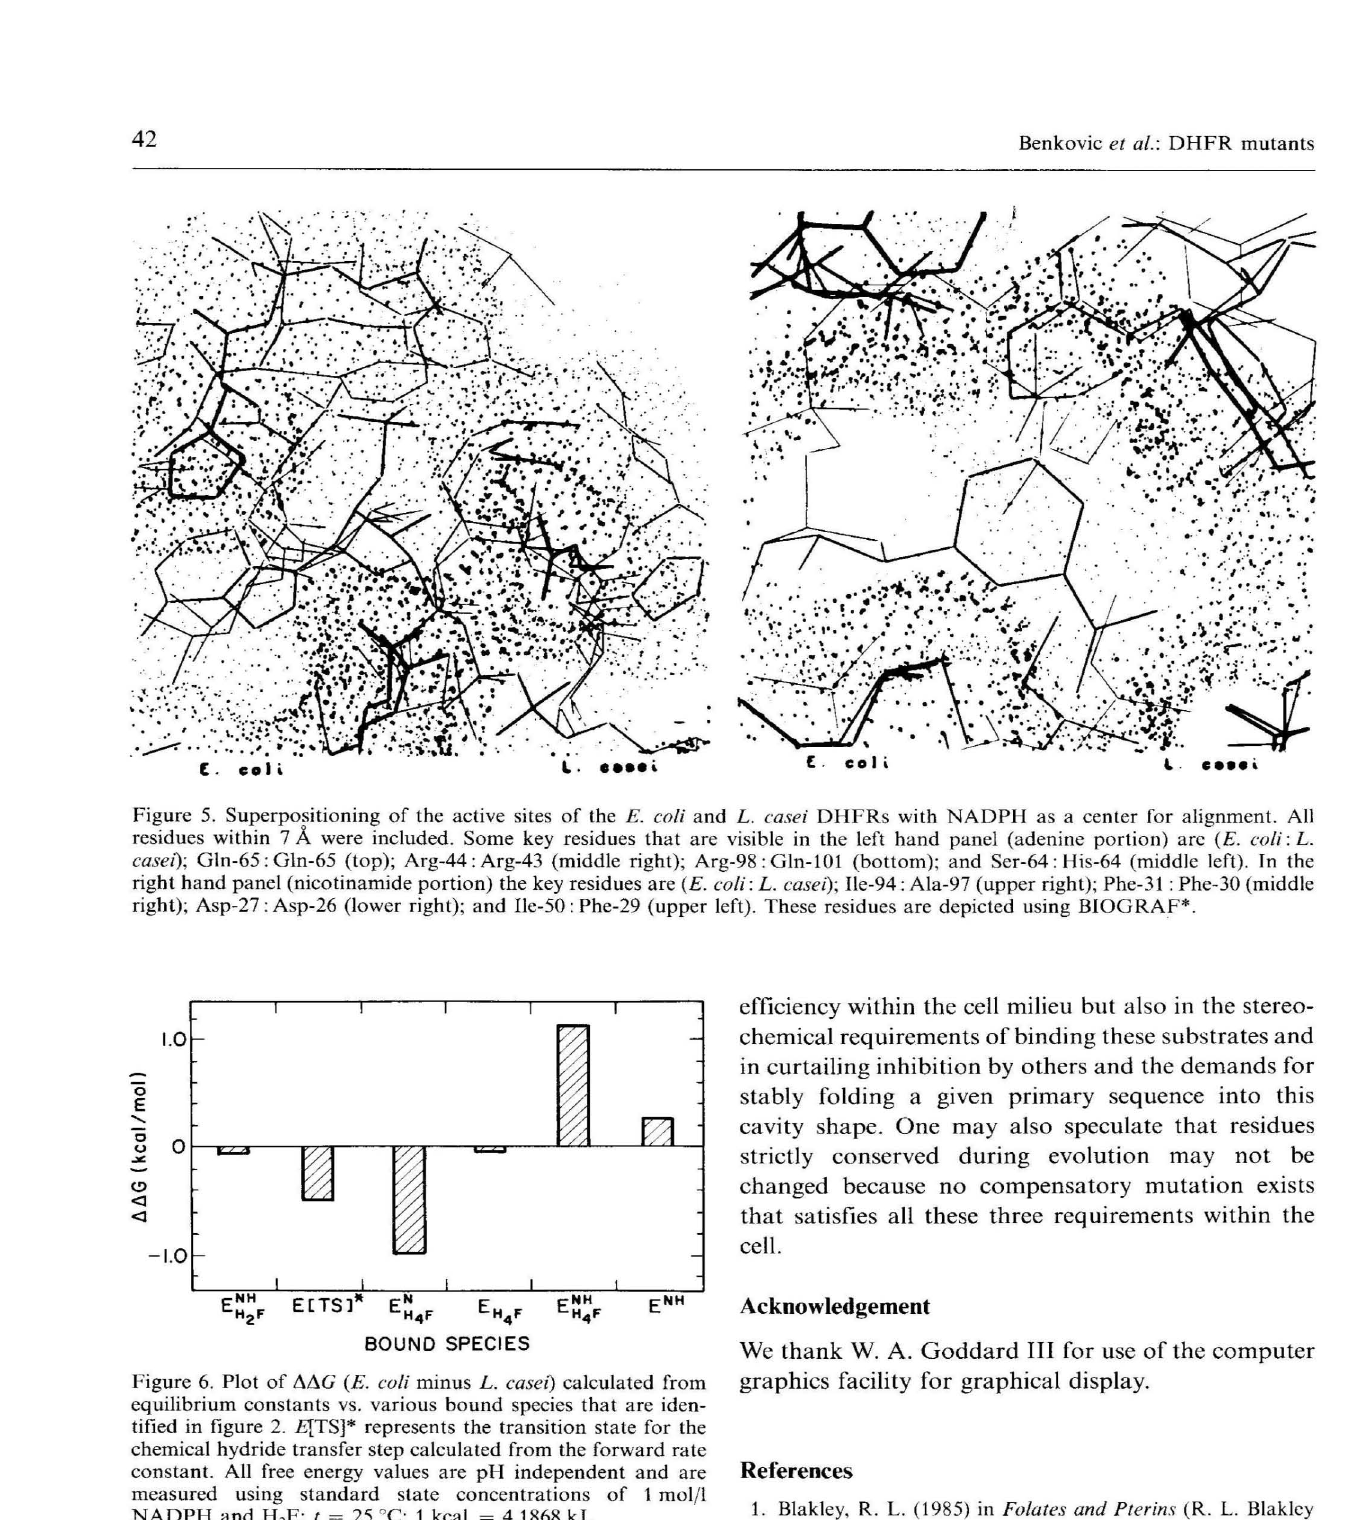
Figure 6. Plot of I1I1G (E. coli minus L. casei) calculated from equilibrium constants vs. various bound species that are iden tified in figure 2. E{TS]* represents the transition state for the chemical hydride transfer step calculated from the forward rate constant. All free energy values are pH independent and are measured using standard state concentrations of 1 molll NADPH and H 2 F; t = 25 °C; 1 kcal = 4.1868